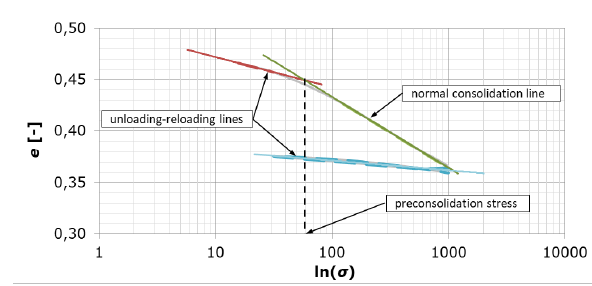
Figure 4: Oedometer-sample compression